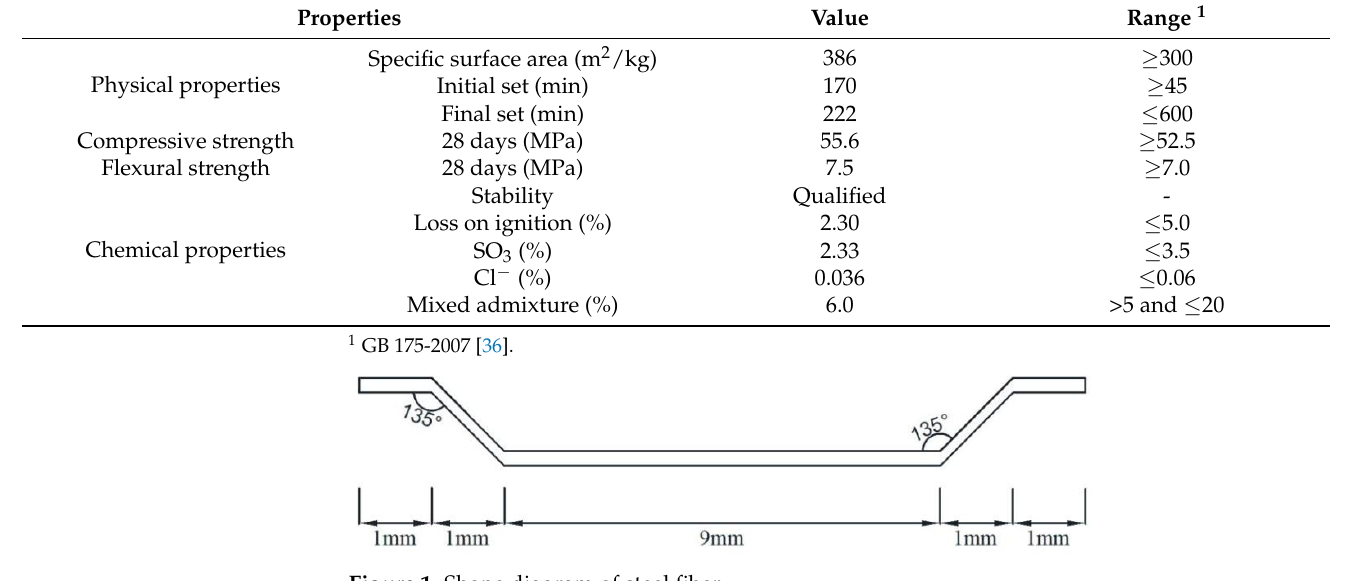
Figure 1. Shape diagram of steel fiber. Table 2. Physical properties of steel fiber.